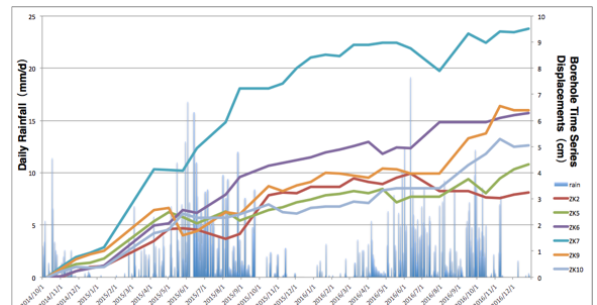
Figure 8. Borehole time series displacements against the daily rainfall